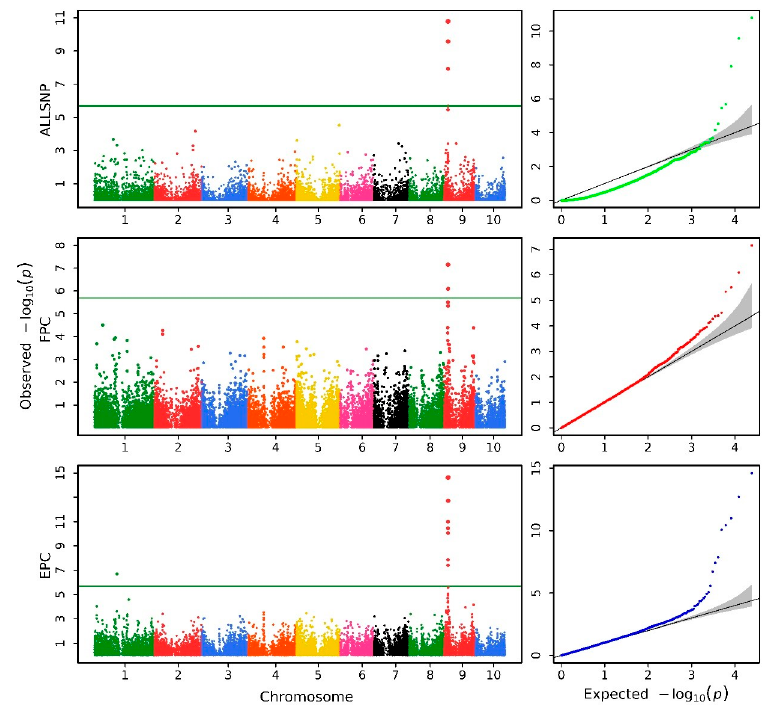
Figure 4. Manhattan plots ( left ) and Q-Q plots ( right ) for the C16:0/C16:1 trait of HAU maize.